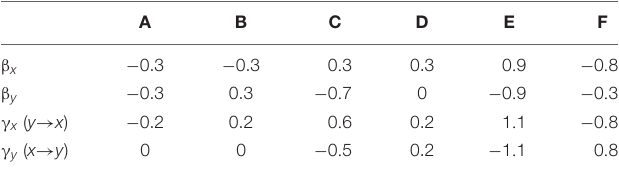
TABLE 1 | Generating time-lagged parameters of the bivariate trajectories in Figure 6